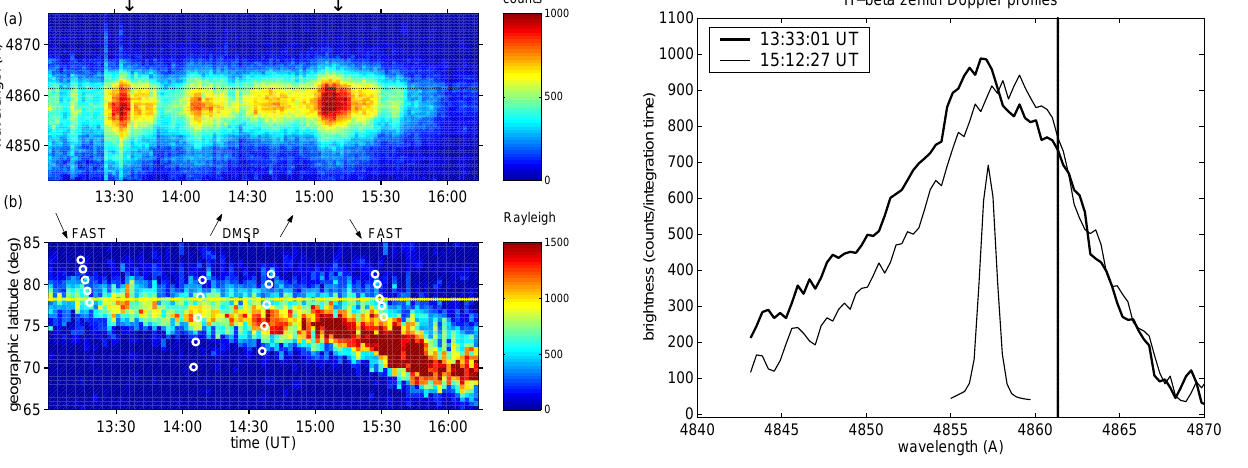
Fig. 1. ( a ) Time series of H β profiles. The arrows mark the times of the profiles in Fig. 2. ( b ) Time history of Lyman– α intensity at lon- gitude of Longyearbyen (15 . 8 ◦ E). Times of the passage of FAST and DMSP satellites over the latitude of Longyearbyen (78 . 2 ◦ N) are marked. Each pass has 5 points at one-minute intervals, centred